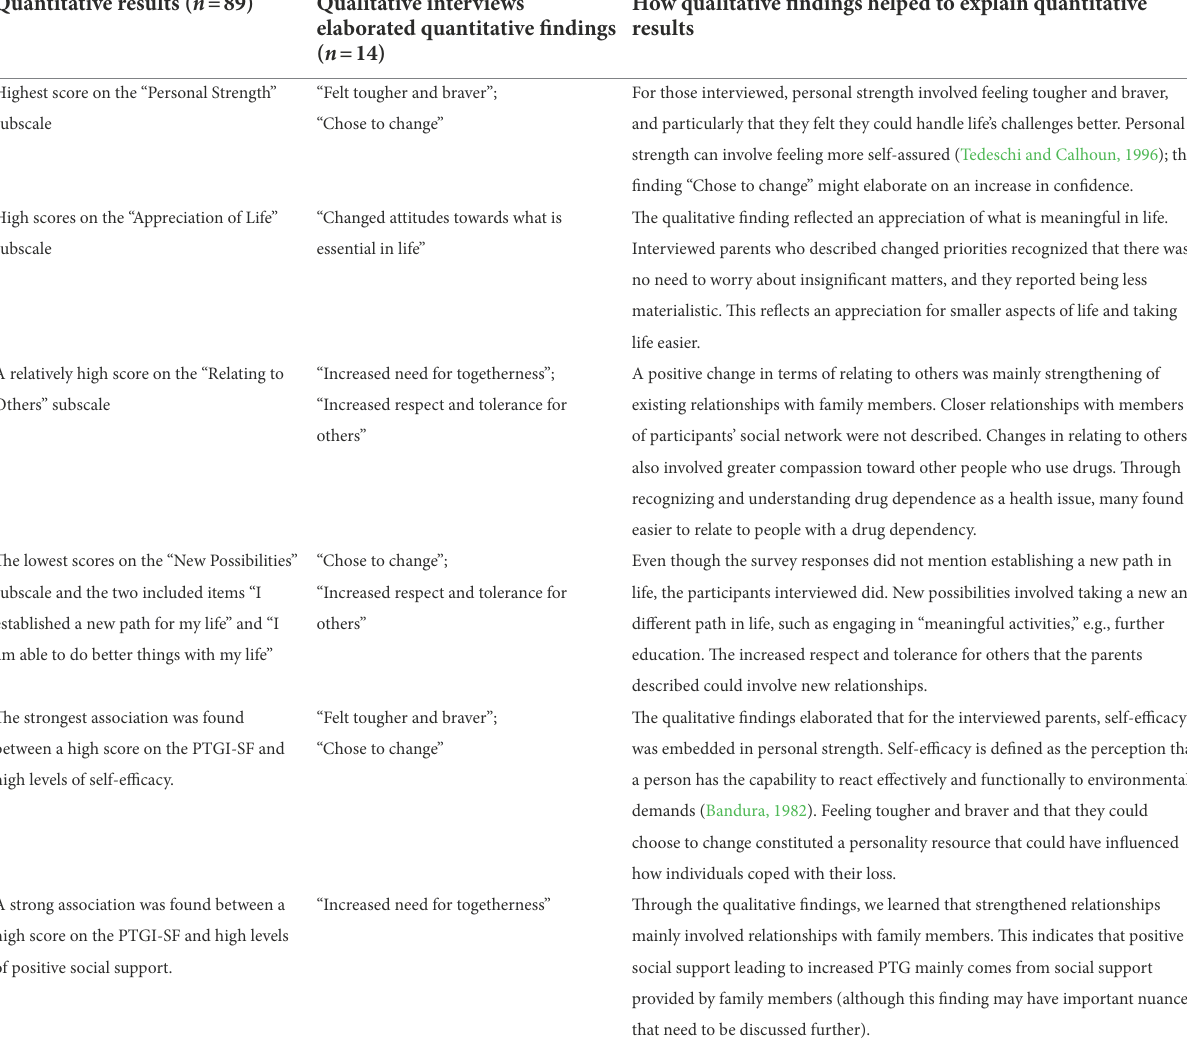
TABLE 6 Integration of survey and interview data in a joint